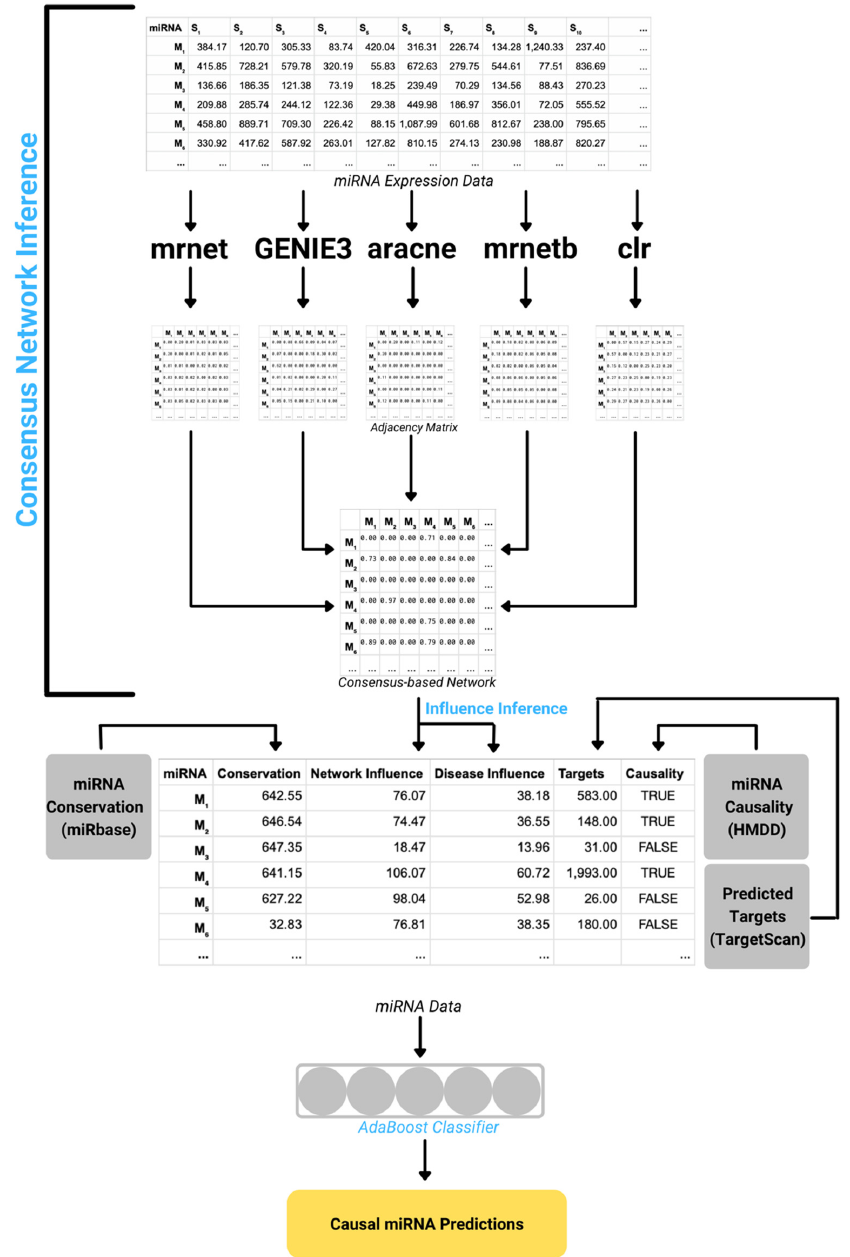
Figure 3. For a disease of interest, DisiMiR constructs a miRNA feature matrix, including whole- network influence, disease-specific influence, and miRNA conservation, in order to infer pathogenic miRNAs. The consensus-based network inference algorithm infers the Consensus Influence Network from the miRNA expression data. This network is used to calculate whole-network and disease-specific influence. These two characteristics are combined with miRNA conservation data from miRbase, target information from TargetScan, and miRNA causality information from HMDD, to create a training dataset. An AdaBoost model is then trained on this dataset to predict disease causal miRNAs.